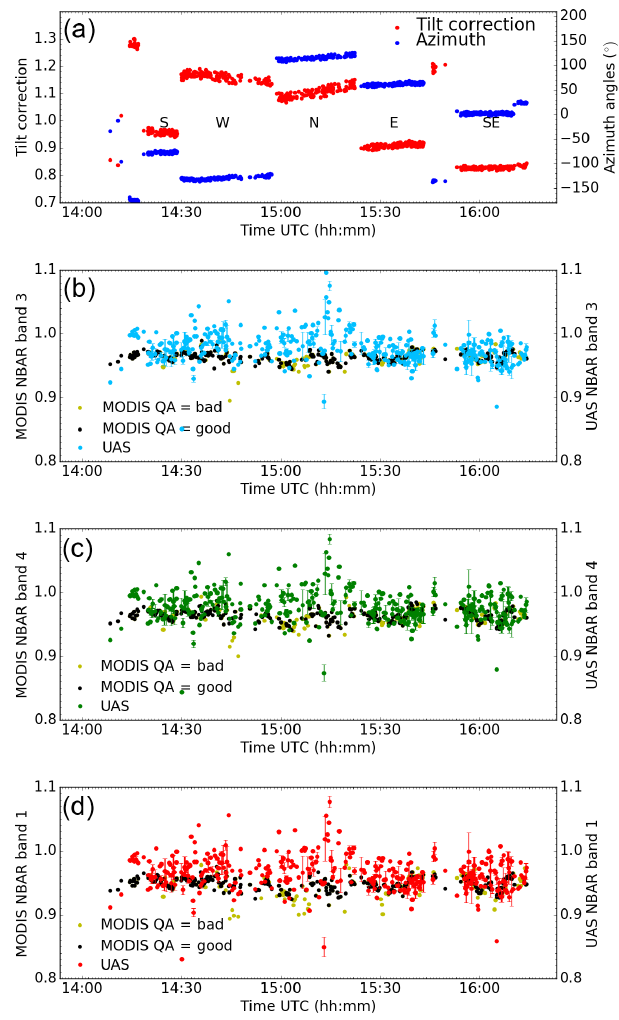
Figure 6. (a) The azimuth angle of the UAS (blue dots) and the tilt correction factor R l /R t , Eq. (3) (red dots). The various flight track elements are identified by letters and correspond to the flight tracks in Fig. 2. (b–d) The MODIS (black dots: good quality; yellow dots: low quality) and UAS band 3 (blue), 4 (green), and 1 (red) NBARs as a function of time. In the case of several UAS data points within one MODIS pixel, the UAS data have been grouped together and presented as a dot with standard deviation. All data from the flight on 6 August